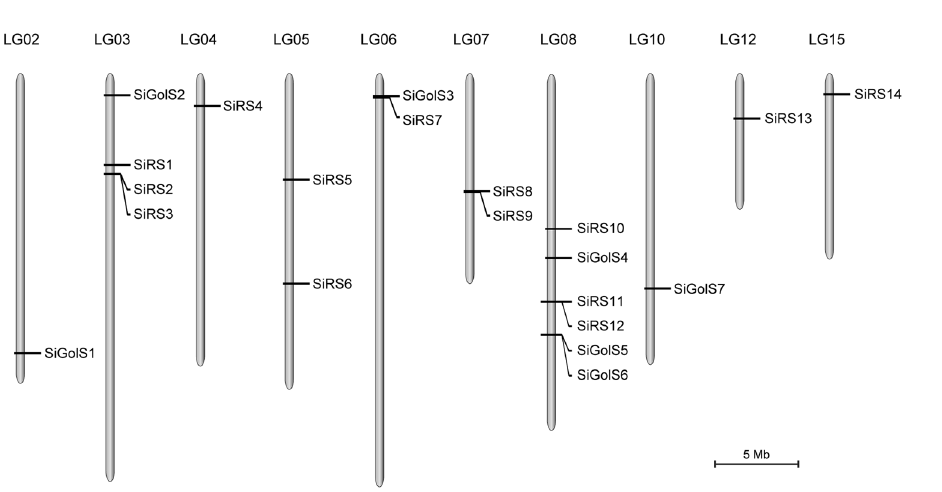
Figure 1. Linkage group distribution of SiGolS and SiRS genes in sesame. Totally 7 SiGolS and 15 SiRS genes were mapped to the 10 linkage groups (LGs) according to their positions in the sesame genome. The LG number was shown on the top of each LG. The scale bar indicated a LG distance of 5